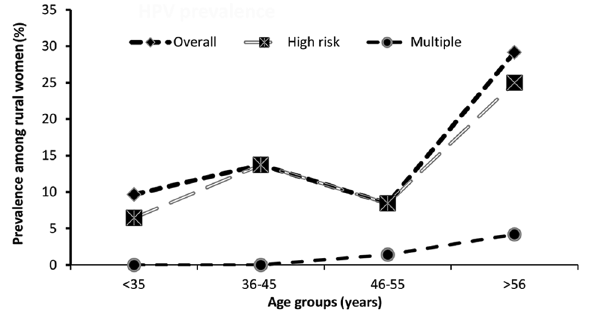
Figure 1. Age-speci fi c prevalence of human papillomavirus (HPV) in 177 women from rural areas in Yunnan,